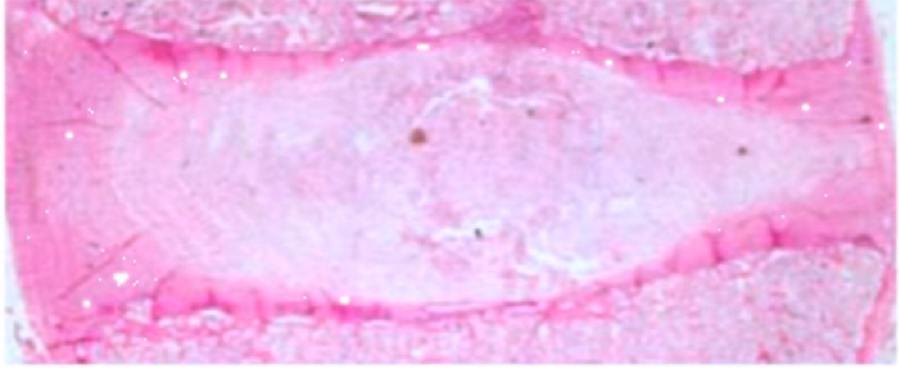
Figure 1. Hematoxylin and eosin (H&E)-stained images under low magnification ( × 50) (own drawing).